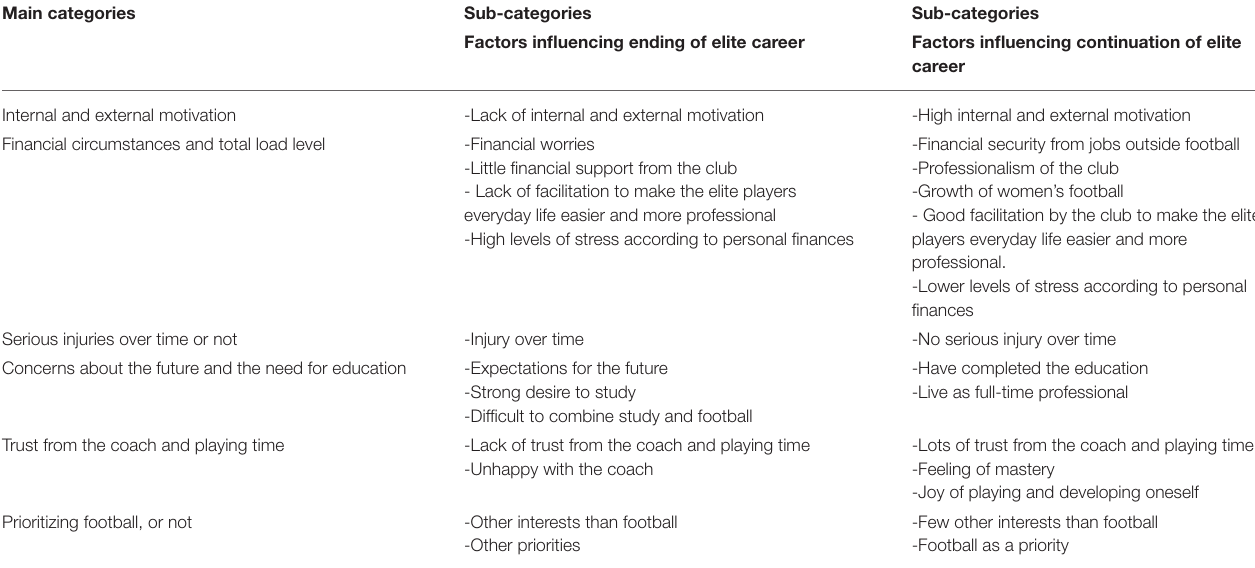
TABLE 1 | Factors influencing elite players either to end or to continue their elite football